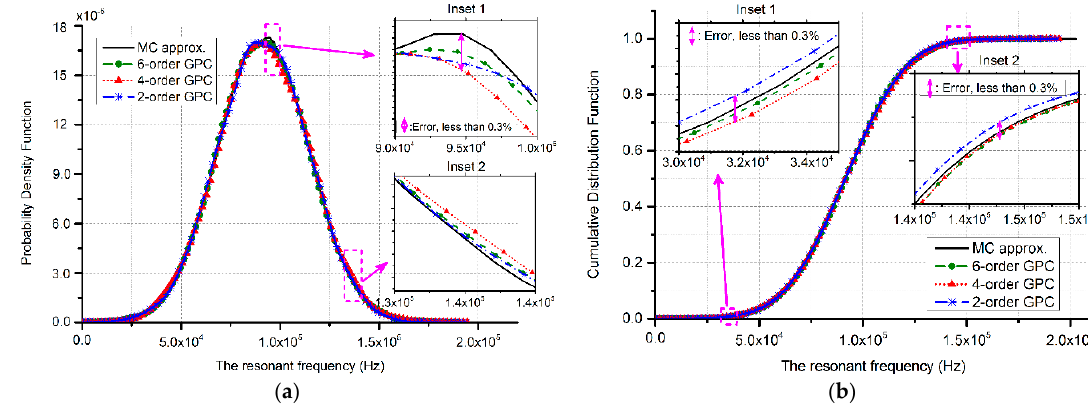
Figure 2. Statistical results of the resonant frequency for the doubly clamped beam approximated by three different orders of GPC methods and MC verifications. The marked insets demonstrate errors within 0.3%. ( a ) PDF; ( b ) CDF.